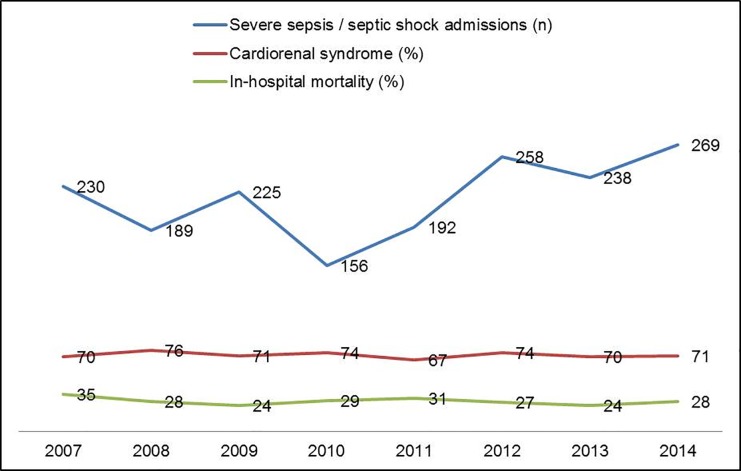
Eight-year trend of total admissions, cardiorenal syndrome and hospital-mortality.Cardiorenal syndrome p-value for trend = .94; In-hospital mortality p-value for trend = .73.